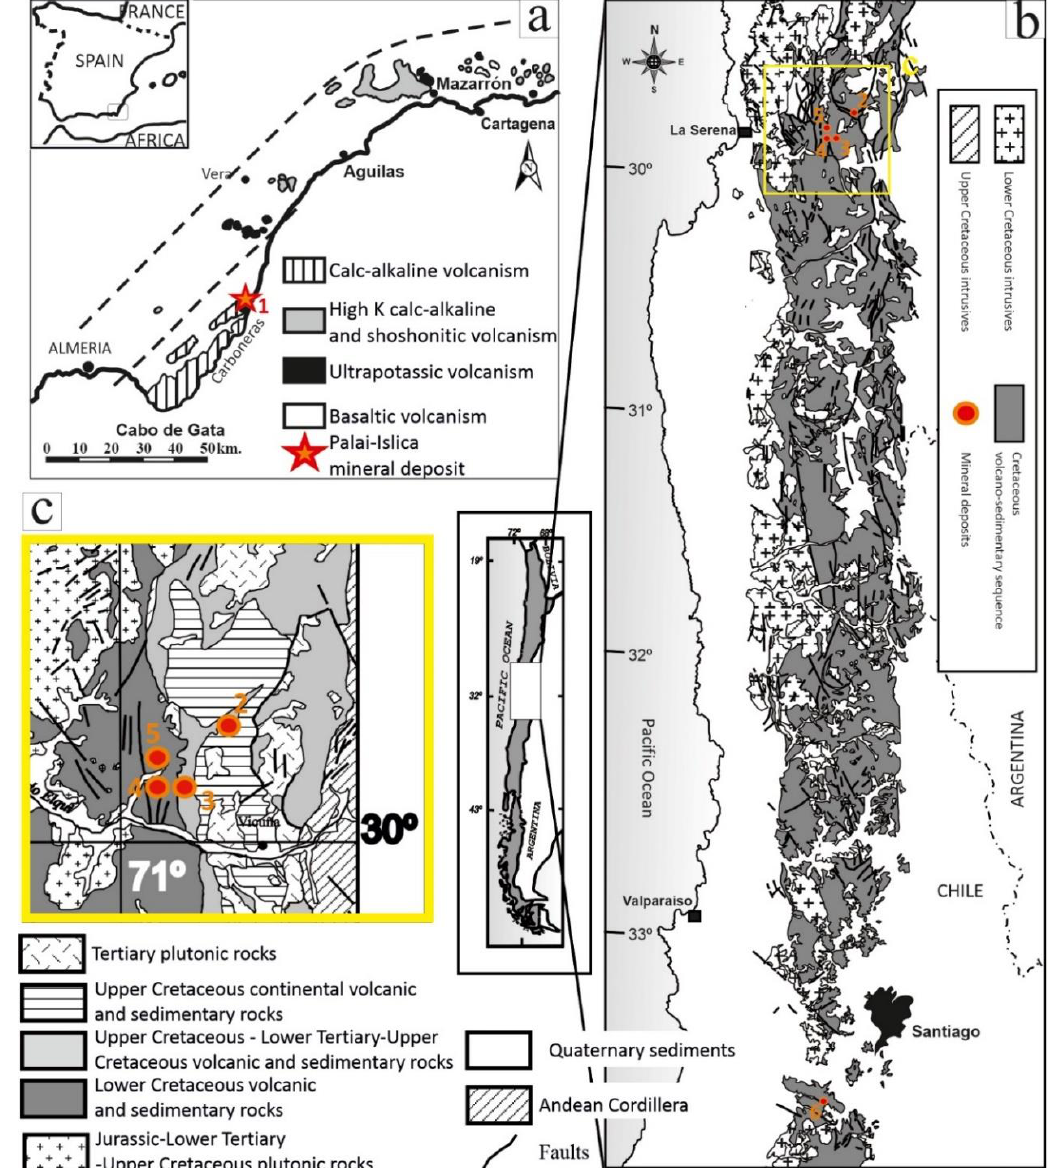
Figure 1. Geological framework of the studied areas. ( a ) Simplified geological map of the Cabo de Gata–Cartagena volcanic province in SE of Spain, with (1) the Palai-Islica, epithermal Au-Cu volcanic-hosted deposit, location (adapted from [23]). ( b ) Simplified geological map of the Lower Cretaceous belt in the Coastal Range of north-central and central Chile showing the studied deposits: (2) El Dorado-epithermal Au-Cu volcanic-hosted-, (3) Quebrada Marquesa—“Chilean Manto-type” Cu(-Ag)-, (4) Quebrada Marquesa - Stratabound Mn-, (5) Arqueros - Ag-Ba epithermal veins-, (6) Melipilla–“Chilean Manto-type” Cu(-Ag)-. ( c ) Geological map of La Serena area, where the majority of the studied deposits are located (adapted from [29,33]).